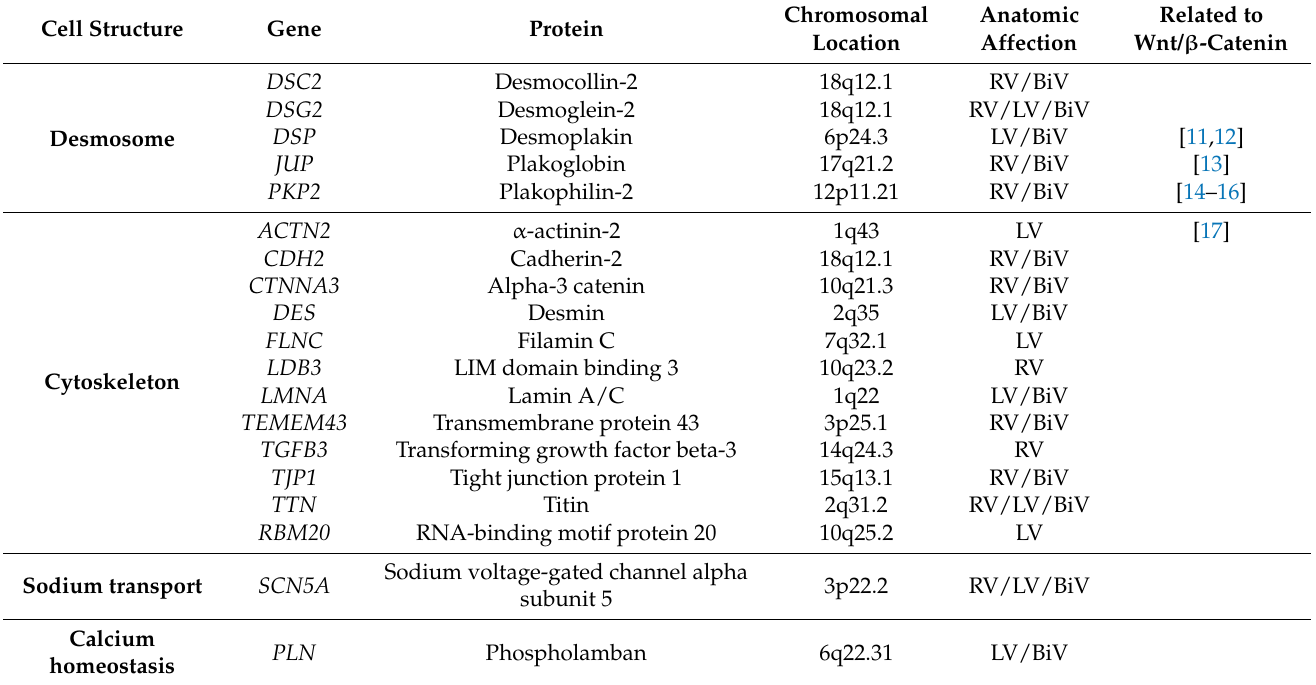
Table 1. List of genes associated with arrhythmogenic